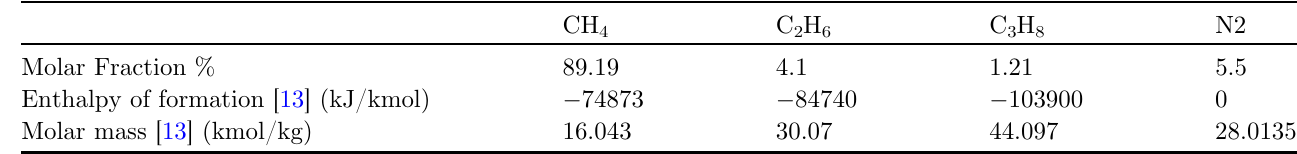
Table 1. Fuel content.